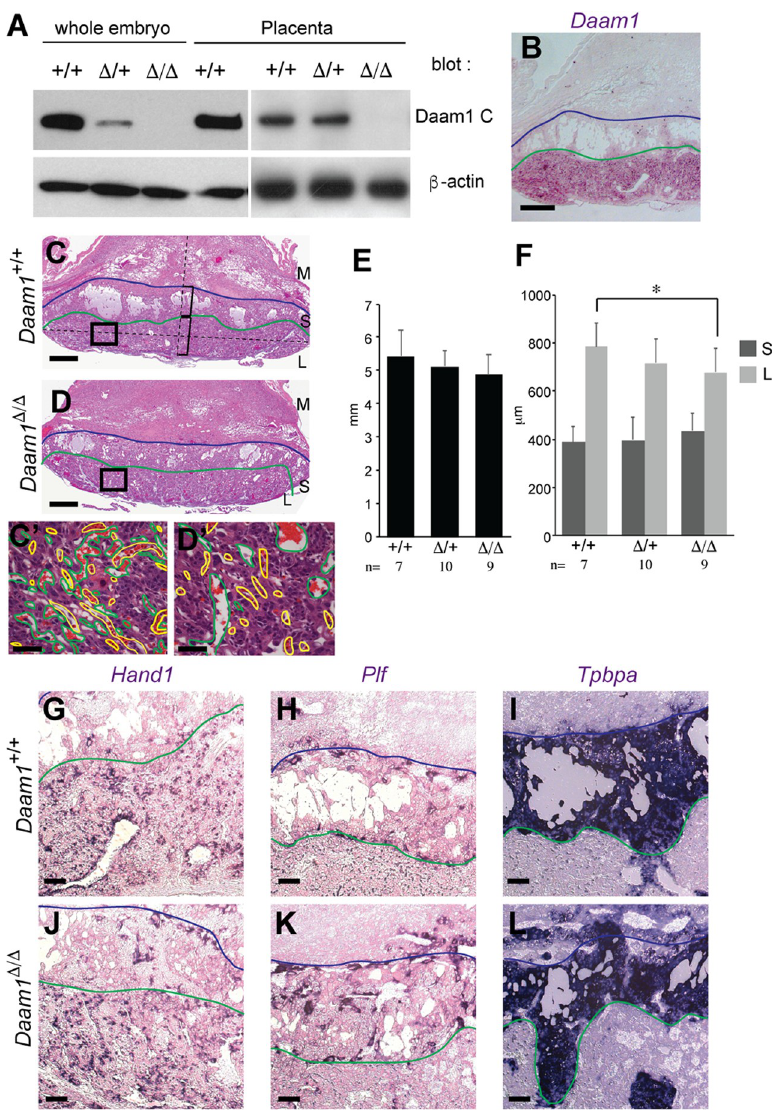
Fig 2. Placental developmental defects in Daam1 -deficient mice. (A) Western blot analysis for Daam1 (top) and β - actin (bottom). Whole embryo lysates and the embryonic part of the placenta from indicated genotypes at E10.5 were used.(B) In situ hybridization of wild-type placenta sections using the Daam1 probe. (C) Daam1 +/+ and (D) Daam1 Δ / Δ placentas at E12.5. High magnification images’ (C’, D’) positions are indicated as boxes on C and D. Maternal blood sinuses (green) and fetal blood vessels (yellow) are labeled with lines on C’ and D’. (E) Size of the placenta of each genotype which was measured as the distance between edges of the boundary between the spongiotrophoblast and labyrinthine layers. (F) Thickness of the spongiotrophoblast layer (S) and labyrinthine layer (L) in each genotype. The thickness of each layers was measured on the line that connected the center of the boundary between spongiotrophoblast and labyrinthine layers and the thickest part of placenta as shown in C. t-test � : p < 0.05. (G-L) In situ hybridization of Daam1 +/+ (G-I) and Daam1 Δ / Δ (J-L) placenta sections using Hand1 (G, J), Plf (H, K) and Tpbpa (I, L) probes. Blue lines depict the boundary between the maternal decidua (M) and spongiotrophoblast layer (S), and green lines depict the boundary between spongiotrophoblast and labyrinthine layers (L). Scale bar = 200 μ m in B, and G-L. 500 μ m in C and D. 50 μ m in C’ and